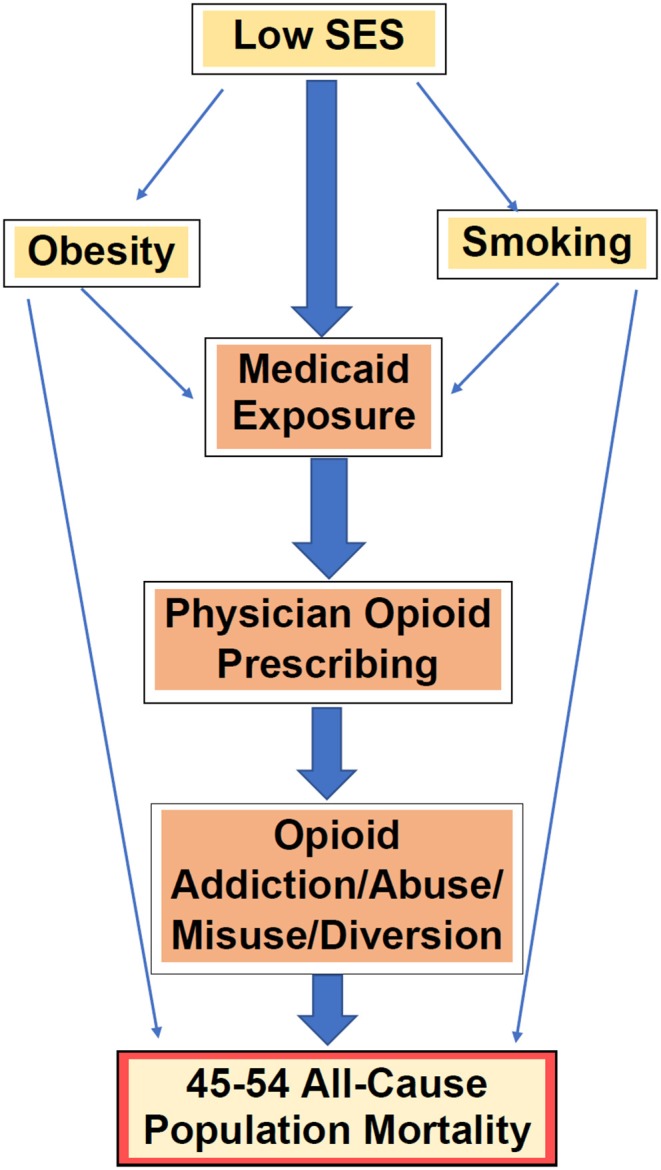
A priori confounders & effect modifiers in the paradigm of Medicaid exposure (as proxy for prescription opioids) and all-cause mortality.